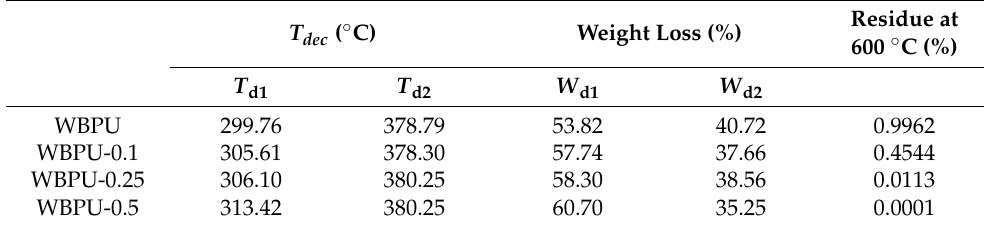
Figure 6. ( a ) TGA and ( b ) DTG curve for WBPU and WBPU-CNF nanocomposite films.